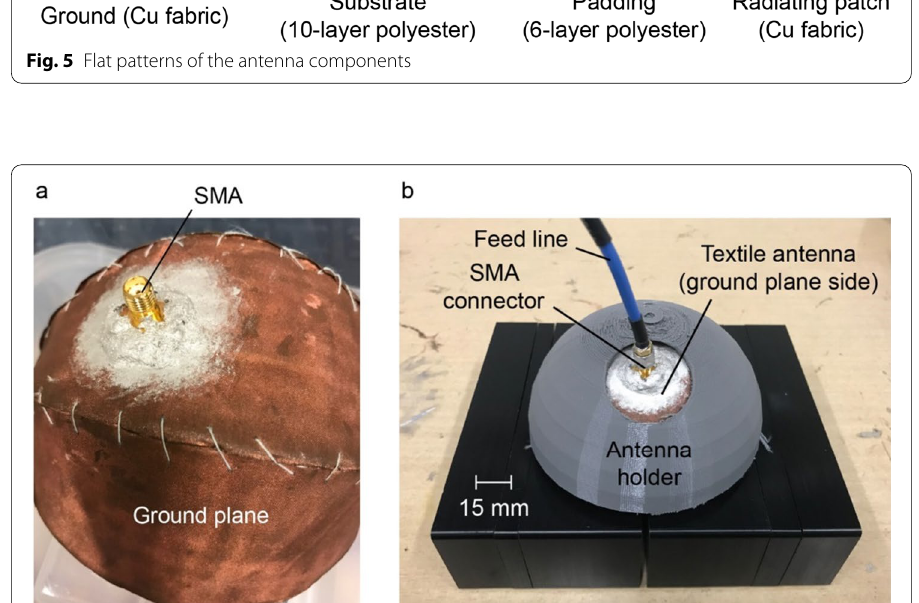
Fig. 6 Antenna sample ( a ) placed in an antenna holder ( b ) for